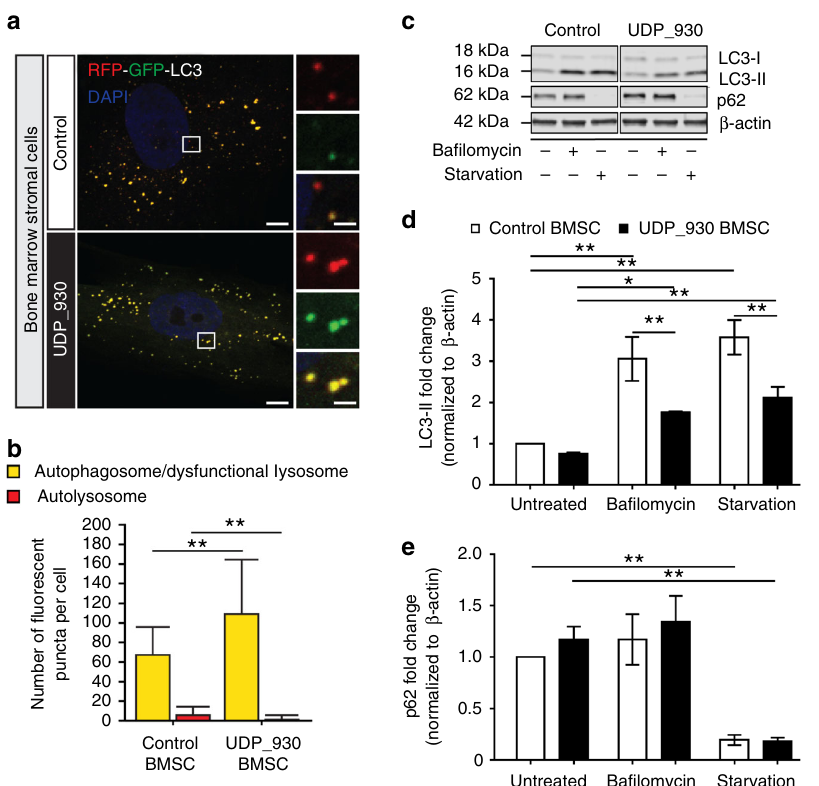
Fig. 4 Autophagy fl ux is impaired in SRS BMSCs. a Confocal micrographs of LC3 fl ux examined through RFP-GFP-LC3 viral transduction in BMSCs. Boxed area (left) indicates magni fi ed area (right) of autophagosomes and/or autolysosomes. b Quanti fi cation (mean ± S.D.; n = 20 cells per sample) of the numbers of autophagosomes/dysfunctional lysosomes (RFP- and GFP-positive puncta) and autolysosomes (only RFP-positive puncta). c Western analysis of cell extracts from BMSCs treated with or without autophagy inhibition (ba fi lomycin) or induction (starvation) with antibodies against LC3, p62, and β -actin. Full size blots with molecular weight markers are included in Supplementary Fig. 6. d , e Quanti fi cation (mean ± S.D.; n = 3 extractions) of LC3-II ( d ) and p62 ( e ) levels normalized to β -actin normalized to untreated control BMSCs. d , e One-way ANOVA post hoc Sidak (comparisons of preselected pairs) test; * P < 0.05, ** P <